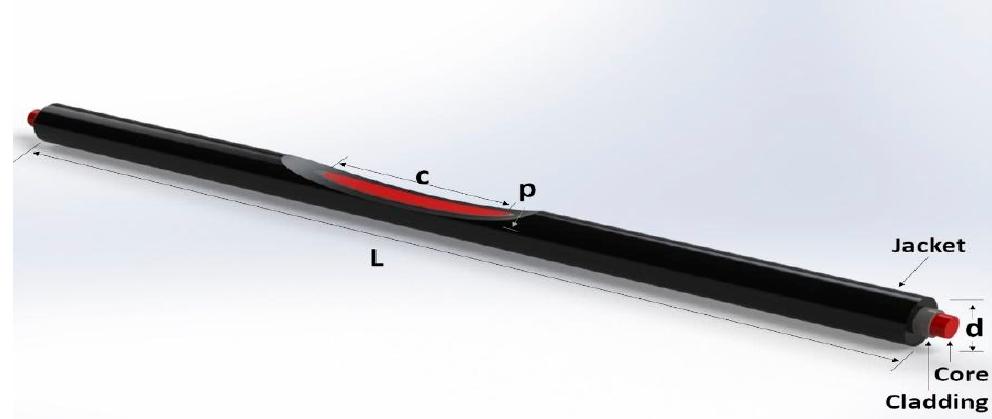
Figure 1. Polymer optical fiber (POF) curvature sensor with the sensitive zone. The optic fiber length is given by L and the optic fiber diameter is d. The sensitive zone length is represented by c and the depth of the cut in the fiber core is p.